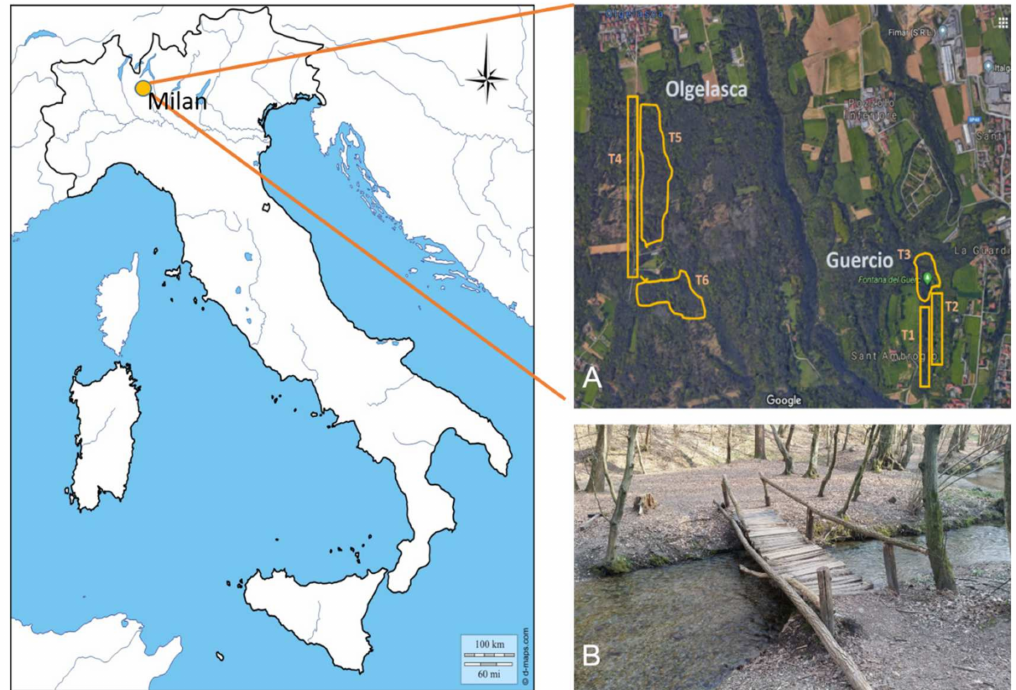
Figure 2. Location of the study area. ( A ) location and area of the transects monitored, identified by the letter T; “Guercio” identifies the main locality on the regional protected area named “Riserva del Guercio” in which the pathogen was first detected. “Olgelasca” identifies the adjacent locality in which the pathogen appeared in 2016. ( B ) picture of the protected area between transect 1 and transect